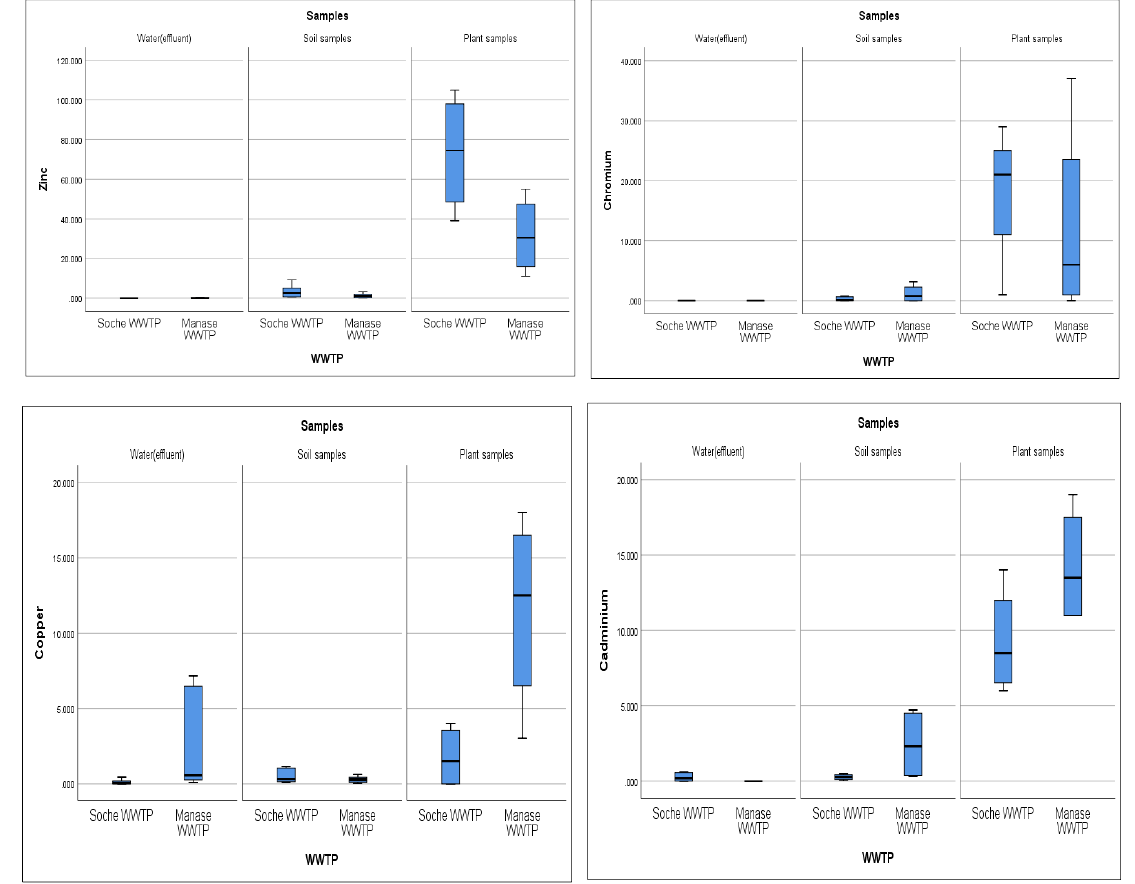
Figure 2. Box plots of heavy metal concentration (mg/L) at Manase and Soche Wastewater Treatment Plants.